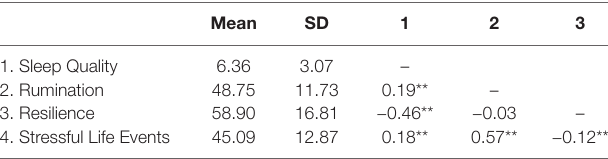
TABLE 1 | Means, standard deviations, and correlations among variables.